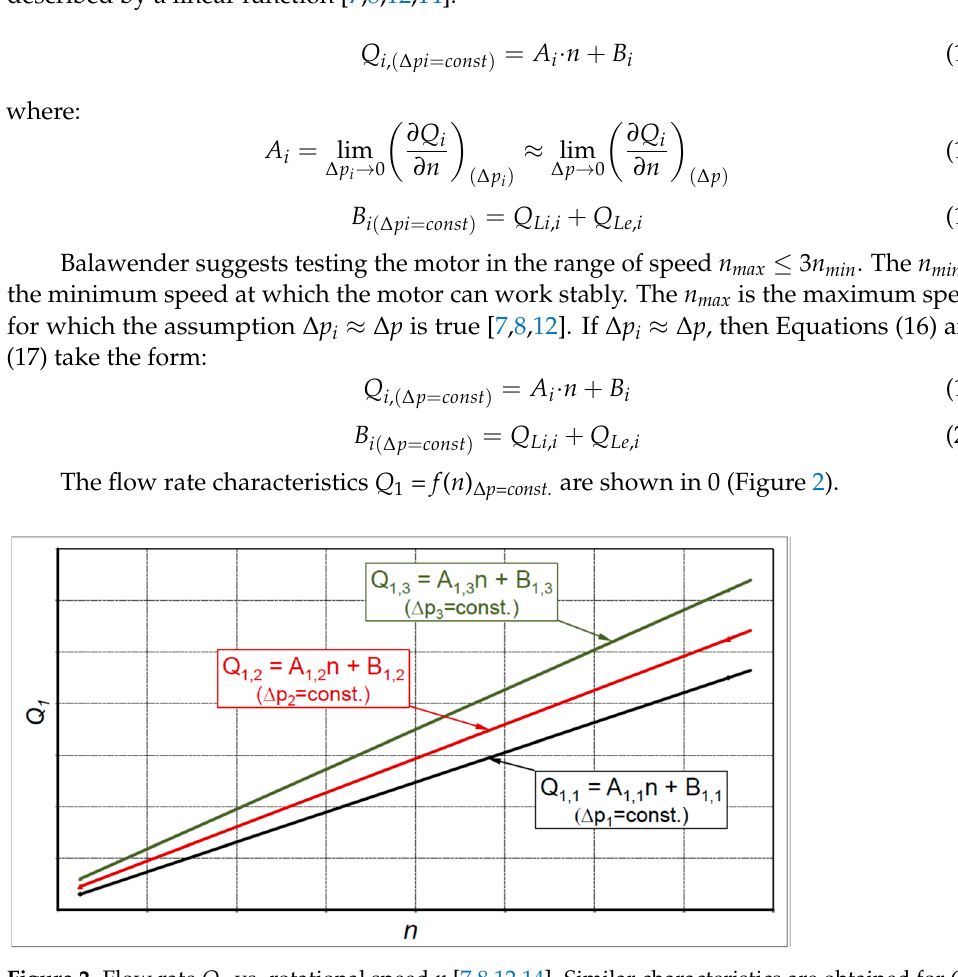
Figure 2. Flow rate Q 1 vs. rotational speed n [7,8,12,14]. Similar characteristics are obtained for Q 2 .